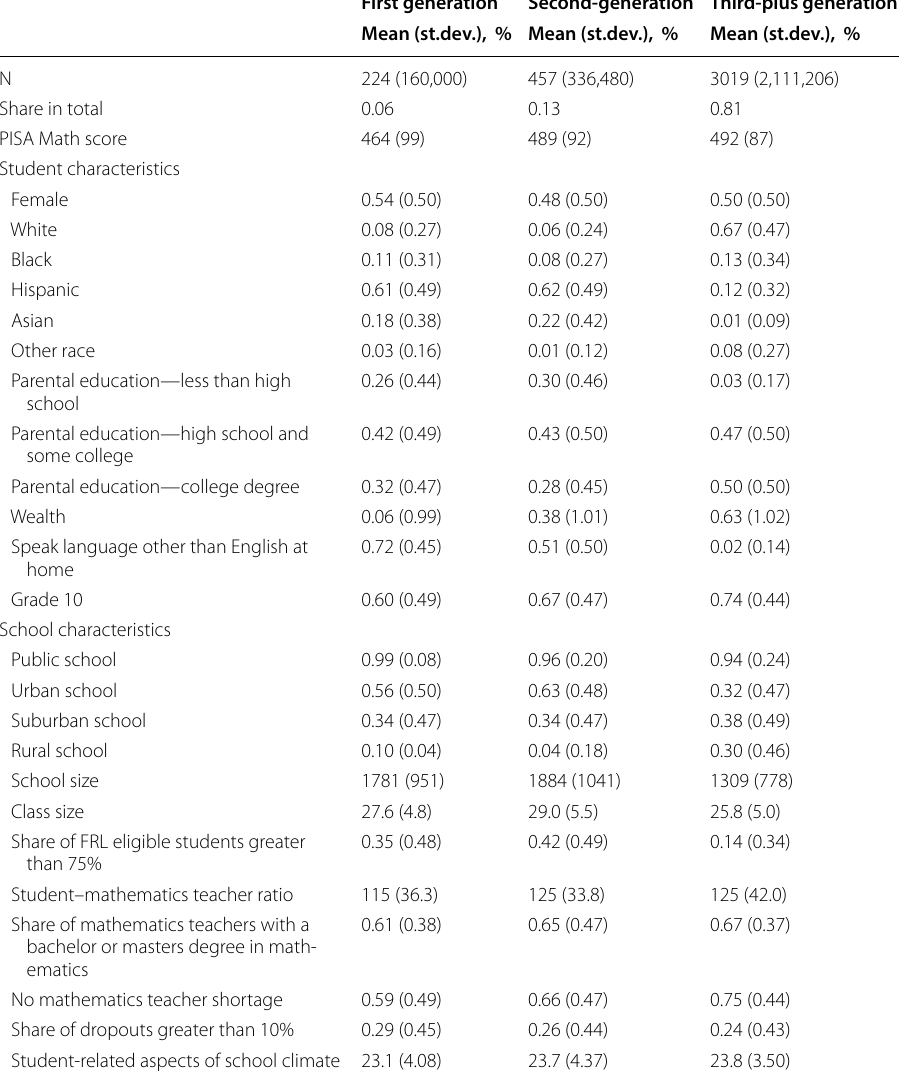
Table 2 Descriptive statistics, three generations, PISA 2012 First generation Second-generation Third-plus